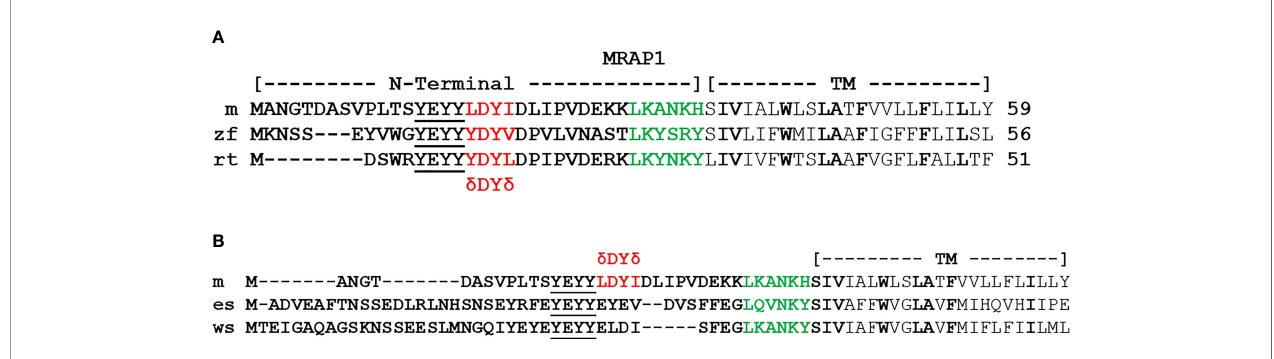
FIGURE 3 | Alignment of bony vertebrate MRAP1sequences. (A) The amino acid sequences of the N-terminal and transmembrane domain of mouse (m) MRAP1 (accession number: NM029844), zebra fi sh (zf) MRAP1(accession number: XP001342923.2), and rainbow trout (rt) MRAP1 (accession number: FR837908). The activation motif is highlighted in red, residues in the proposed extended activation site are underlined, and residues in the proposed reverse topology motif are highlighted in green. Identical residues in the Transmembrane Domain (TM) are highlighted in bold. (B) Comparison of mMRAP1, elephant shark (es) MRAP1 (accession number: XM_007903550.1), and whale shark (ws) MRAP (accession number: XM_020520012.1). The activation motif of mMRAP1 is highlighted in red. Identical residues in the proposed reverse topology motif are highlighted in green. Identical residue in the TM domain are highlighted in